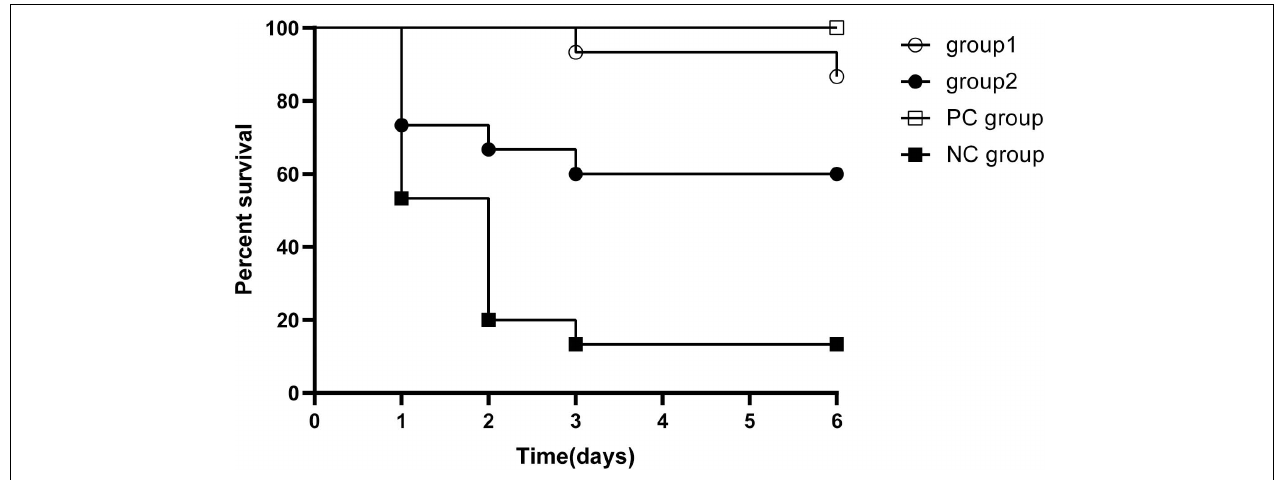
FIGURE 1 | Survival rate in pneumonia mice. All mice inhaled 20 µ L P. aeruginosa D4 (2.5 × 10 9 CFU/ml). Group 1 ( n = 15) inhaled 10 µ l phage KPP10 (10 µ l 4 × 10 11 PFU/ml) at 2 h post bacterial inoculation. Group 2 ( n = 15) inhaled 10 µ l phage KPP10 (10 µ l 4 × 10 11 PFU/ml) at 8 h post bacterial inoculation. Negative control (NC) group inhaled 10 µ L of phage buffer at 2 h post bacterial inoculation and the positive control (PC) group received subcutaneous injection imipenem/cilastatin sodium (25 mg/kg) at 2 h post infection and at every 12 h interval for 3 days. Survival rate in group 1, group 2 and PC mice were significantly higher ( p < 0.01) when individually compared with the survival rate of NC mice. CFU denotes colony forming unit. PFU denotes plaque forming